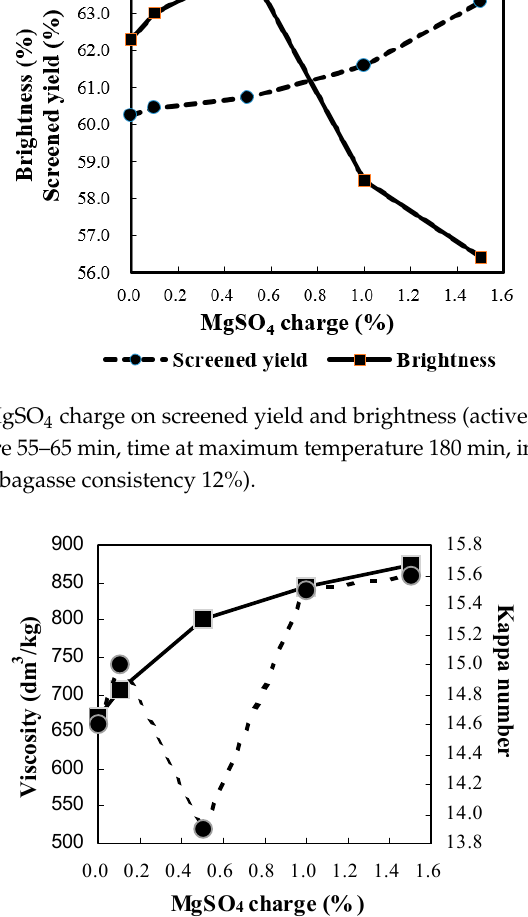
Figure 4. Influence of MgSO 4 charge on viscosity and Kappa number (the same cooking conditions with Figure 3).